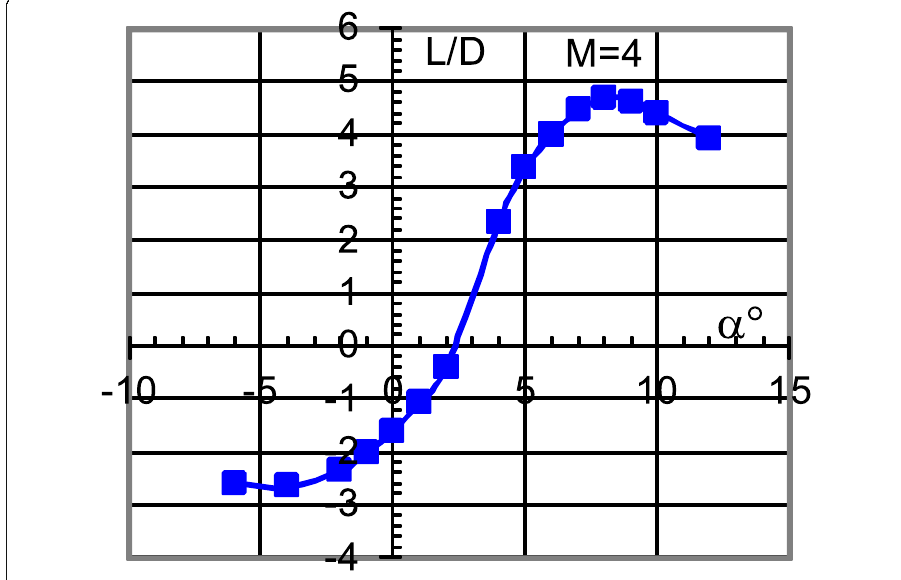
Fig. 8 The results of wind-tunnel tests of the vehicle based on the Busemann biplane concept: aerodynamic efficiency, L / D vs. angle-of-attack